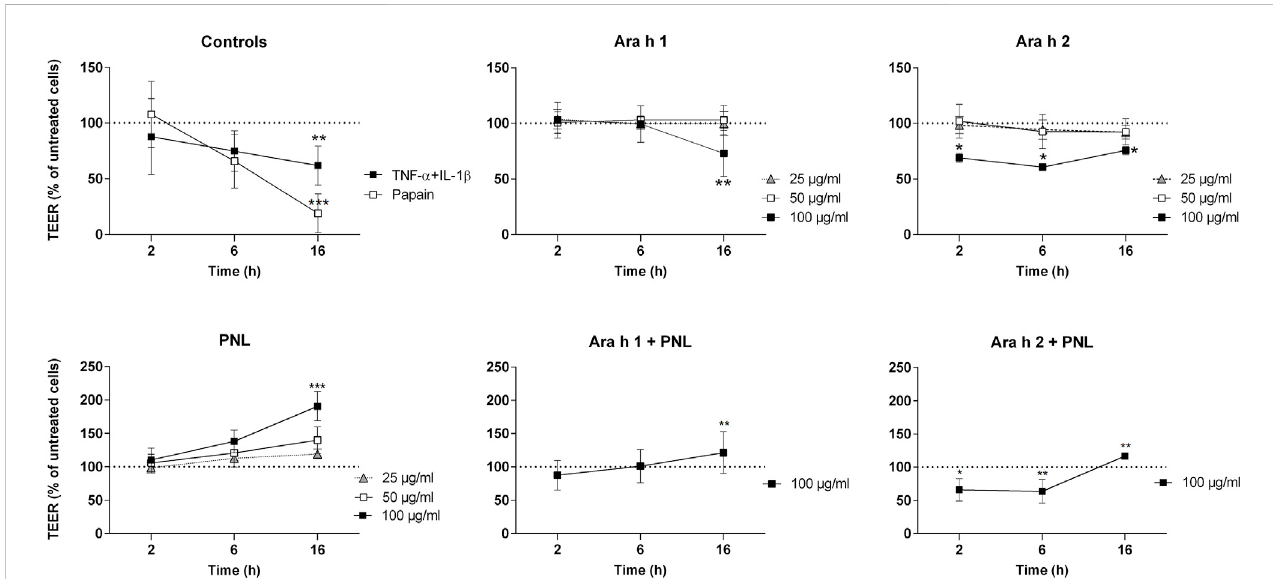
FIGURE 1 Impact of peanut allergens and lipids on the permeability of polarized 16HBE14o- cell monolayers. Treatments were applied apically to cell monolayers and the TEER was measured 2, 6, and 16 h after treatment. Positive controls were papain and the combination of TNF- α and IL-1 β . Ara h 1, Ara h 2, and PNL were used at different concentrations (25, 50, and 100 μ g/mL). Cells were also treated with a combination of Ara h 1 + PNL and Ara h 2 + PNL (the concentration of the single component was 100 μ g/mL). TEER values of untreated cells were set as 100% and are indicated by dashed lines. Data show the mean ± SD of three independent experiments. * p < 0.05, ** p < 0.01, *** p <